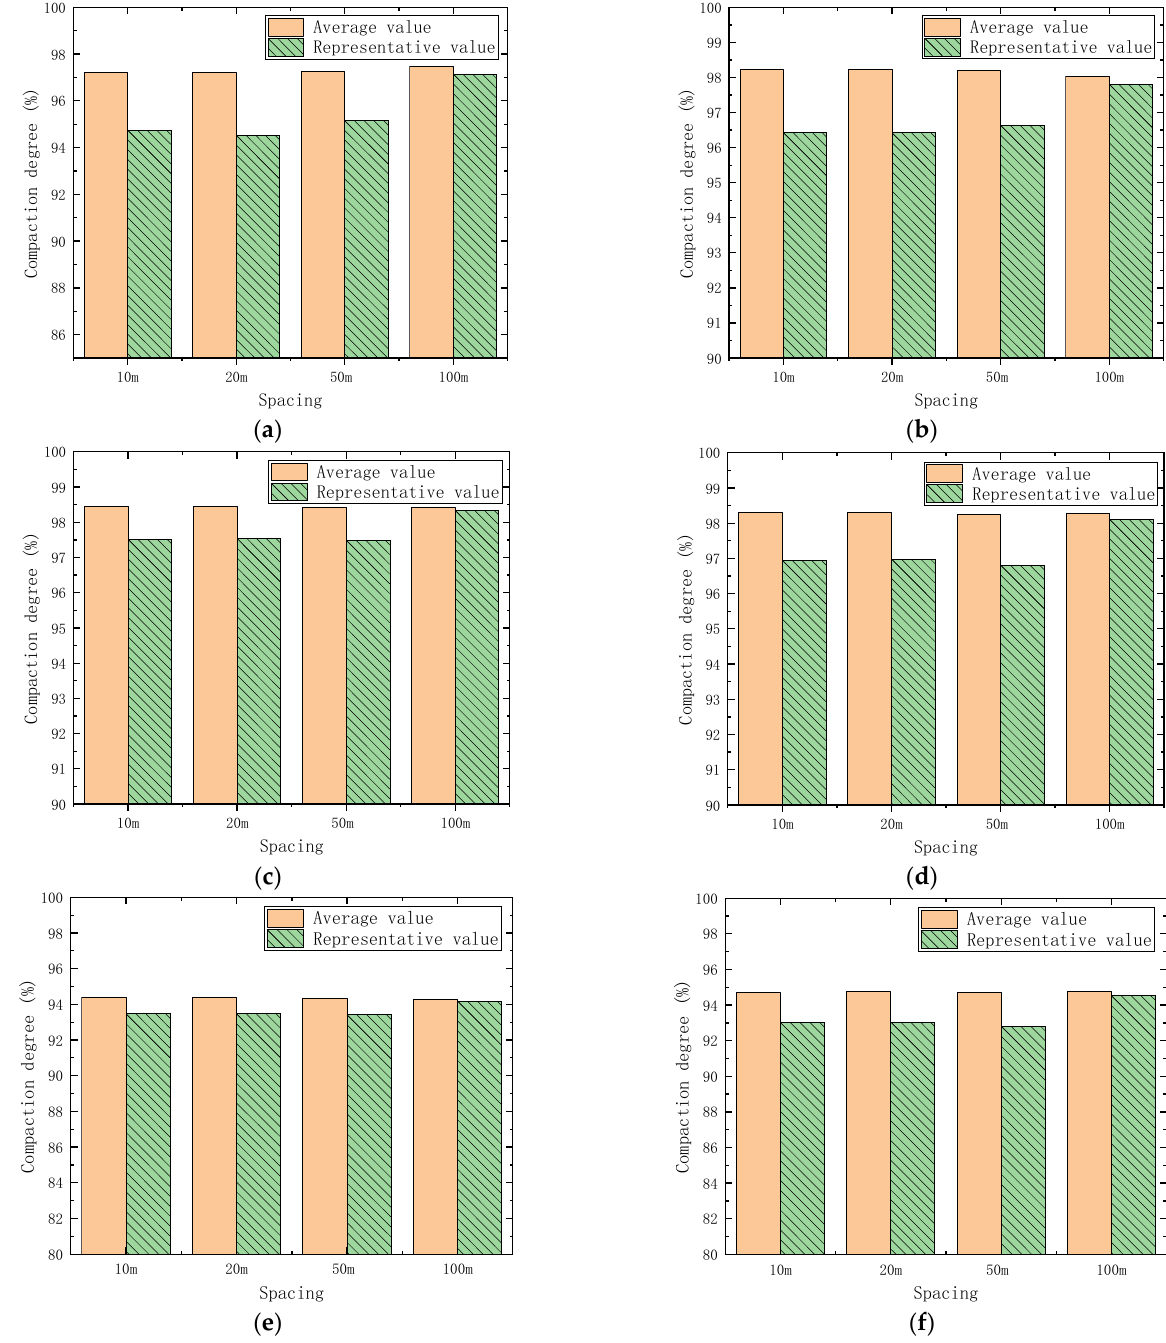
Figure 11. Average value and representative value of compaction degree: ( a ) Test section A; ( b ) Test section B; ( c ) Test section C; ( d ) Test section D; ( e ) Test section E; ( f ) Test section F.